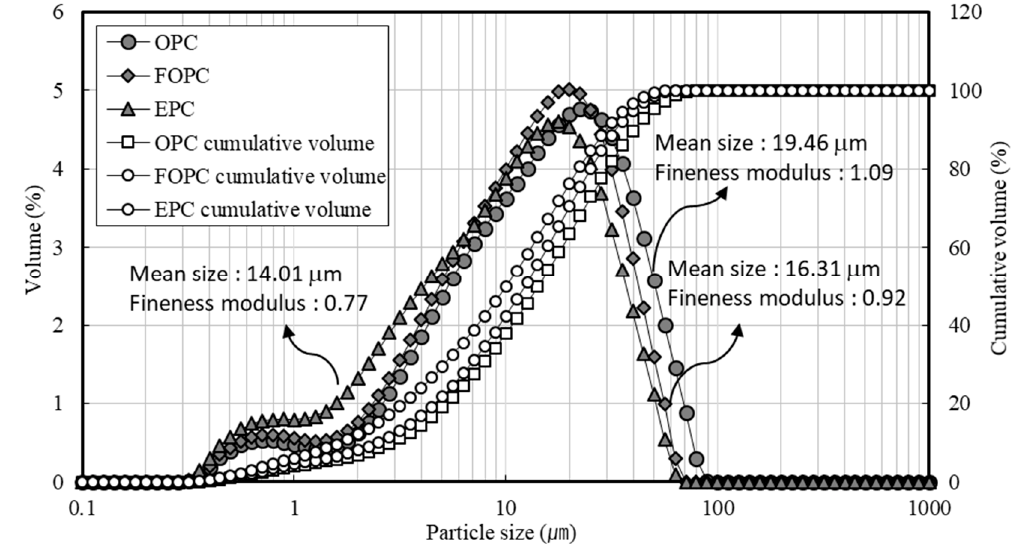
Figure 3. Particle size distribution for OPC, FOPC, and EPC.